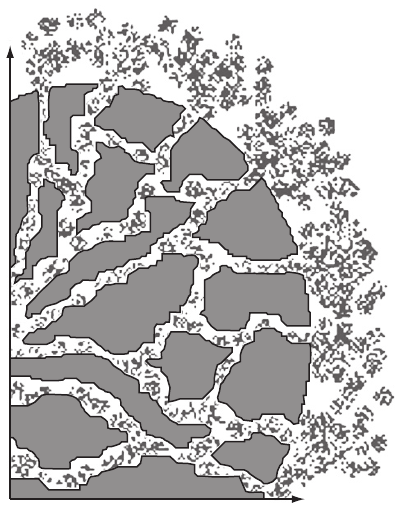
Figure 3. Schematic illustration of particulate materials loss due to the flow of gaseous product from the pellet at high temperatures.